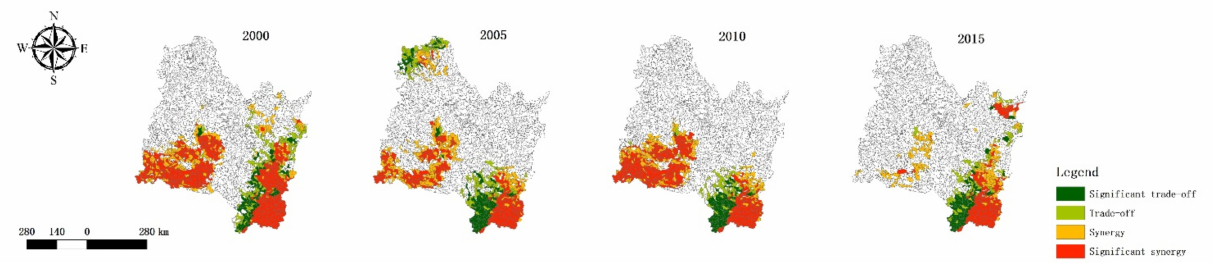
Figure 15. The synergy/trade-off relationship between carbon sequestration and biodiversity. The synergy/trade-off relationship between crop production and water retention in the spatial characteristic from 2000 to 2015 is shown in Figure 16 and Table S1. Overall, there is a trade-off relationship between crop production and water retention between 2000 and 2010. The trade-off relationship is mainly distributed in four regions: the northern and eastern parts of the Songnen Plain, the lower Songhua River, the southern area of Changbai Mountain, and the eastern part of the Lesser Khingan Mountains. The Songnen Plain and the lower reaches of Songhua River are dominated by arable land, and the soil types are mainly phaeozems and chernozems. The characteristics of the trade-off between crop production and water retention in this area show that the crop production has a high-value accumulation and the water retention is low, with the two reflecting a trade-off relationship. The trade-off areas of Changbai Mountain and the Lesser Khingan Mountains are dominated by coniferous forests and broadleaf forests, and the soil types are luvisols, cambisols, and gleysols. The characteristics of the trade-off between